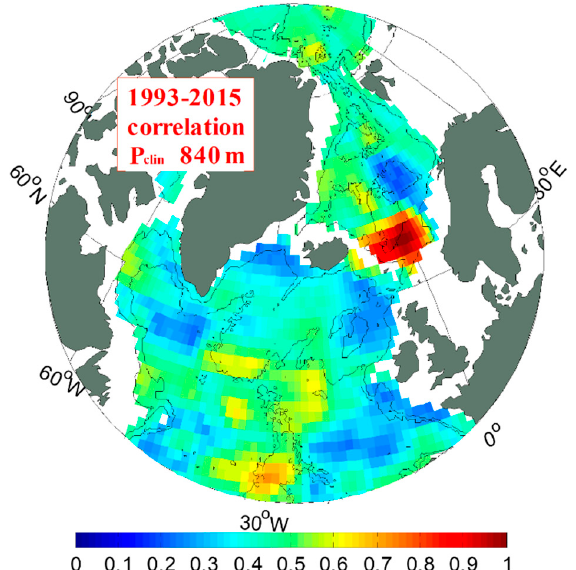
Figure 8. The correlation between P clin and P clin at selected stations in the Norwegian Sea. The time series of the correlation analysis has undergone a 12-month moving average processing. The correlation here is the maximum correlation within 5 years of lead or lag time. The selected stations in the Norwegian Sea are shown in Figure 1 as a purple square. The time series of ∆ P trop , ∆ P clin , and ∆ P are all carried on a 12-month moving mean to remove seasonal fluctuations in this figure. For the sake of comparison, ∆ P clin and ∆ P are shown as anomalies.